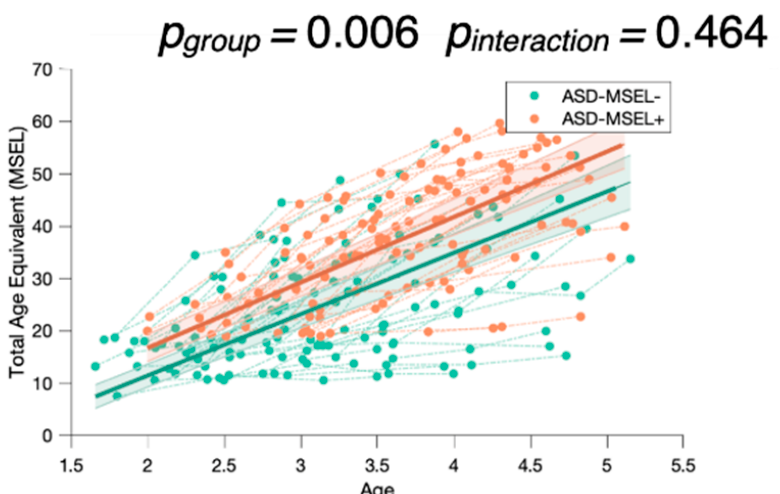
Figure A1. Mixed model analysis for the MSEL Total Age Equivalent, comparing children with either higher ( ASD-MSEL+ ) or lower ( ASD-MSEL- ) global development scores (Total AE score), with more or less attention to face at baseline. The group-level trajectory (bold line) is derived from mixed-effect modeling [43–45]. The 95% confidence interval is indicated by the colored bands around the estimated group-level